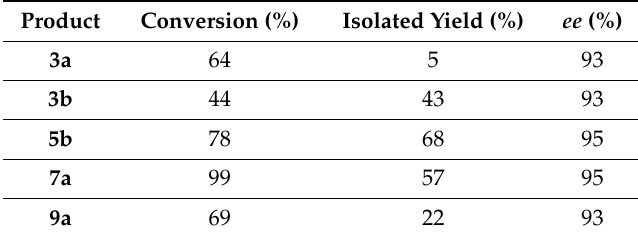
Synthetic performance of Ec PDH E1 on preparative scale. Ec PDH E1